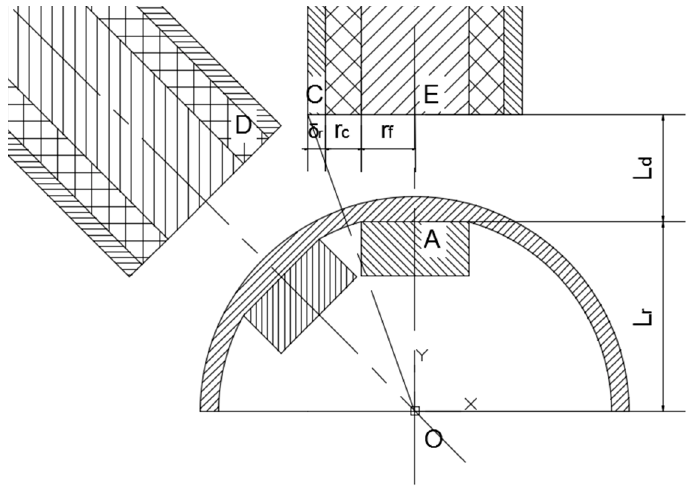
Figure 5. The relationship between maximum coil turns and the distance between the stator and the rotor (cutaway view).